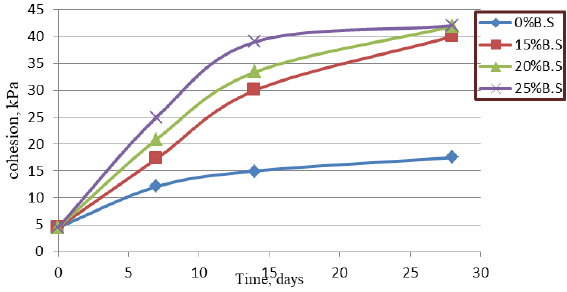
Figure 4: Influence of bacterial solution with time on the